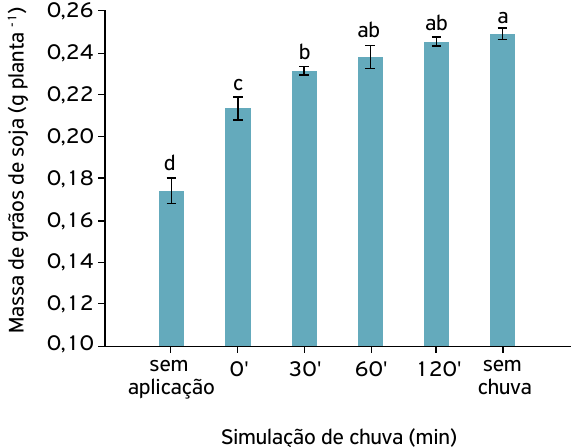
Figura 4. Massa de grão de soja (g grão ‑1 ) na média dos regimes hídricos e intervalos de simulação de chuva após a aplicação. Itaara – RS,